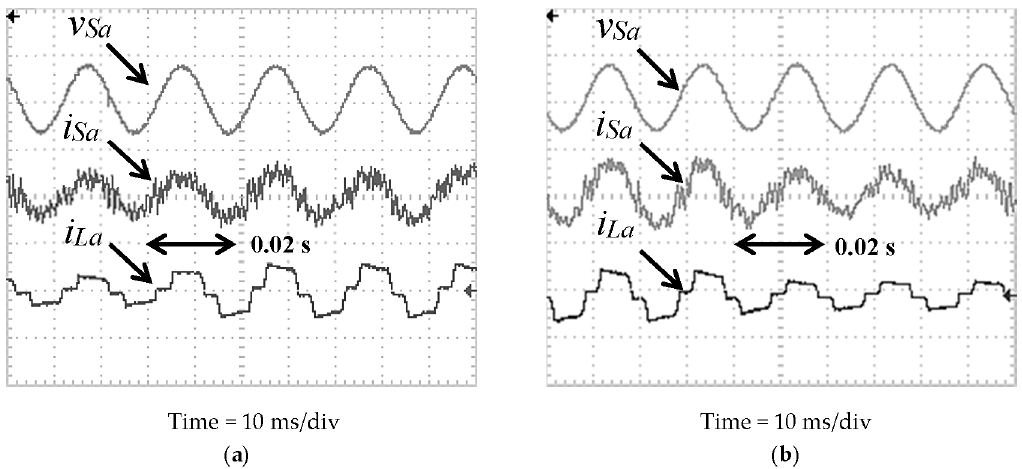
Figure 20. Experimental results of SAPF utilizing the proposed FLC-based current control scheme which includes the phase a source voltage v Sa (100 V/div), source current i Sa (10 A/div), and load current i La (10 A/div), obtained under transient-state conditions of ( a ) low to high and ( b ) high to low currents.